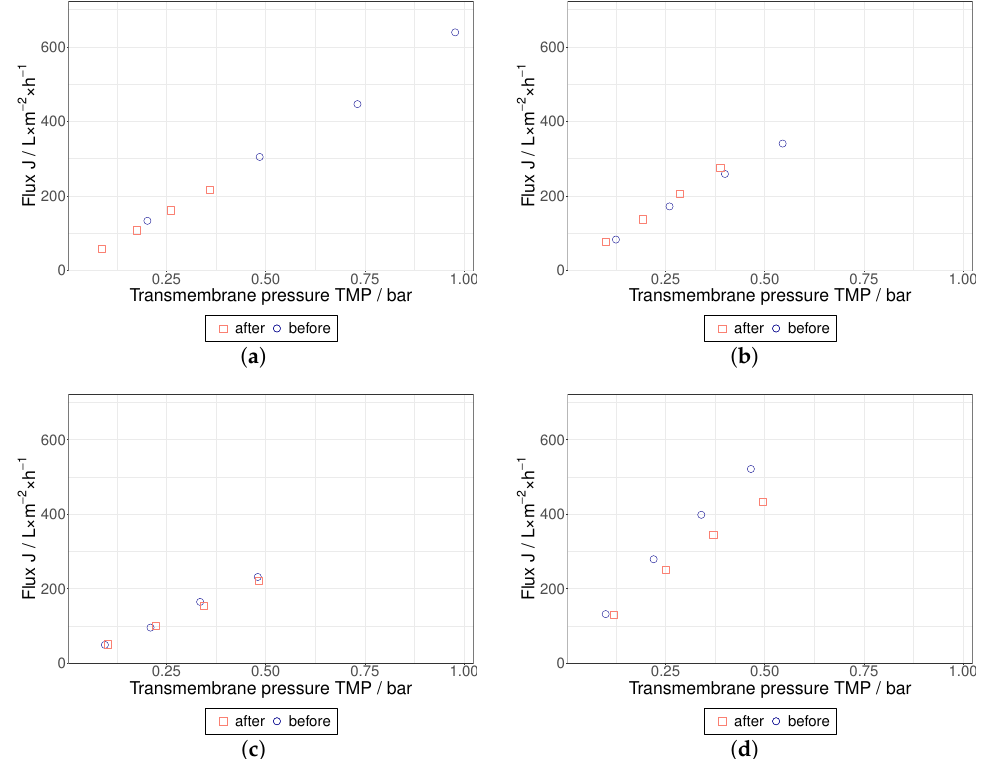
Figure 6. Flux of water over the TMP for each membrane was measured before and after tangential flow filtration trials; ( a ) 100kDa, ( b ) for 300kDa and ( c ) 500kDa and ( d ) for 750kDa